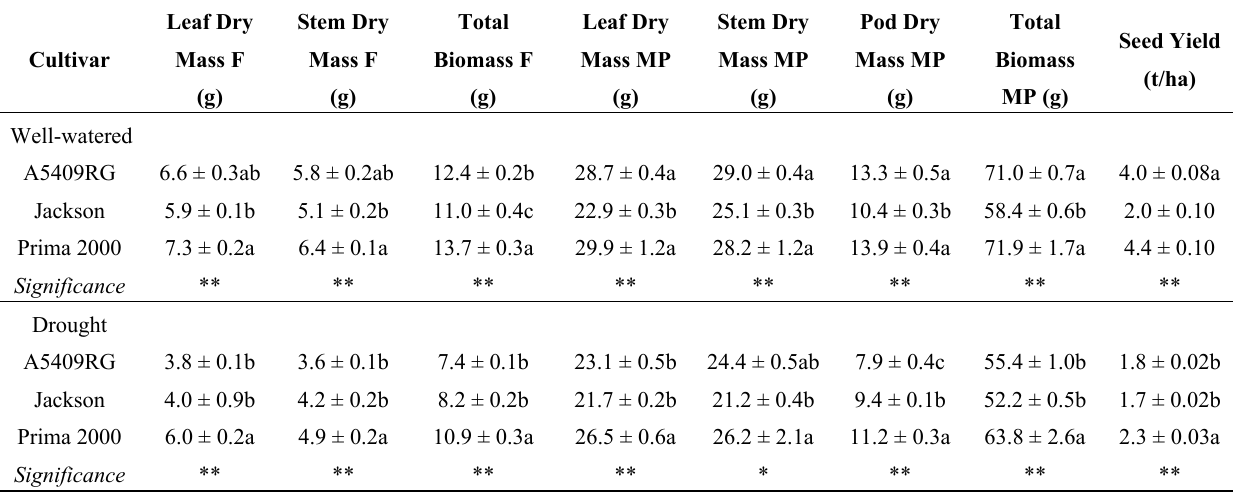
Data represent the mean ± SEM of three replications under both well watered and drought conditions. Biomass at flowering and mid pod filling stage was taken on six representative individual plants per plot. Different letters within a column denote a significant difference ( p <